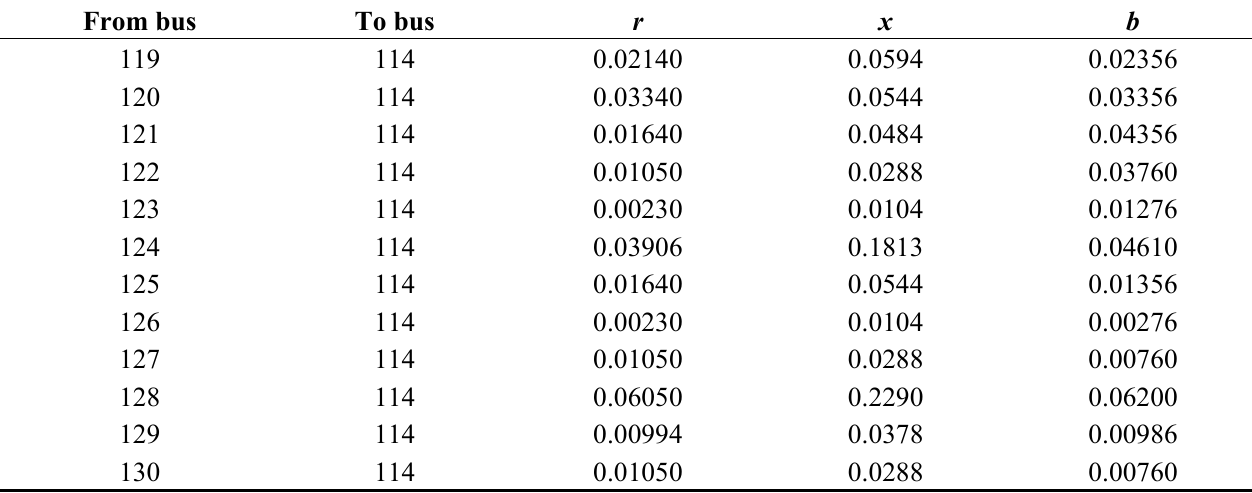
Table A5. Branch